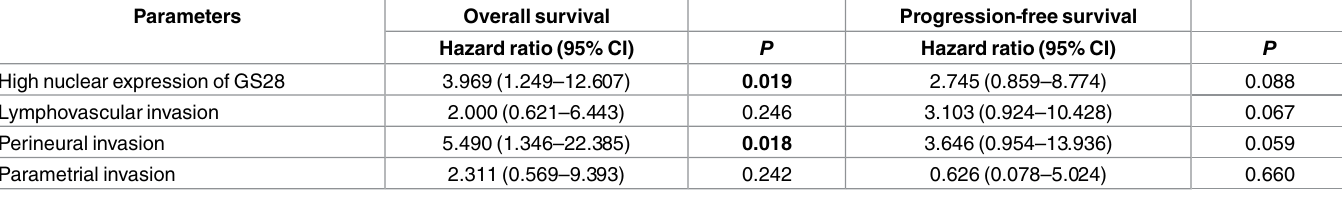
Table 5. Multivariate Cox regression analysisfor overall survivaland progression-free survivalin negative-lymph node-metastasissubgroup (N = 132) of cervical cancerpatients. Parameters